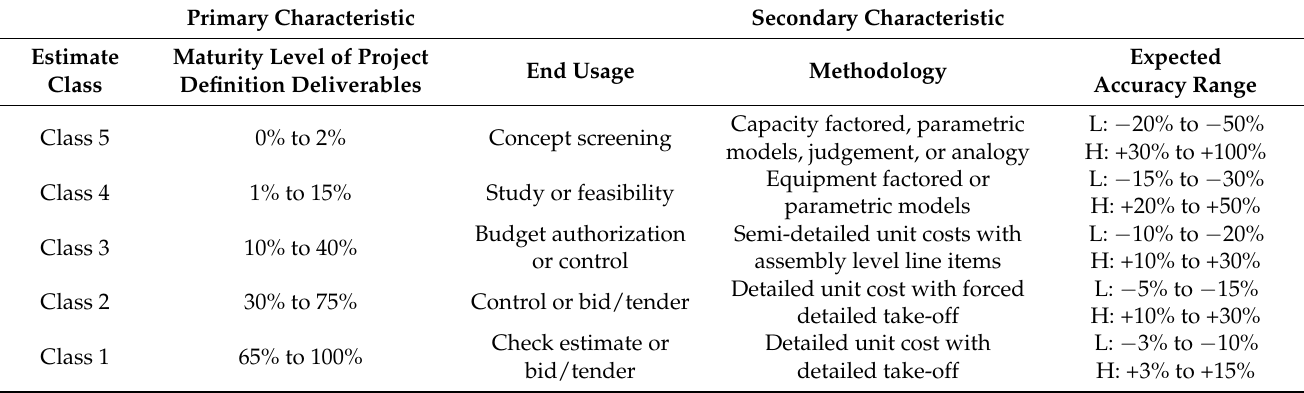
Table 7. Cost estimate classification matrix for process industries